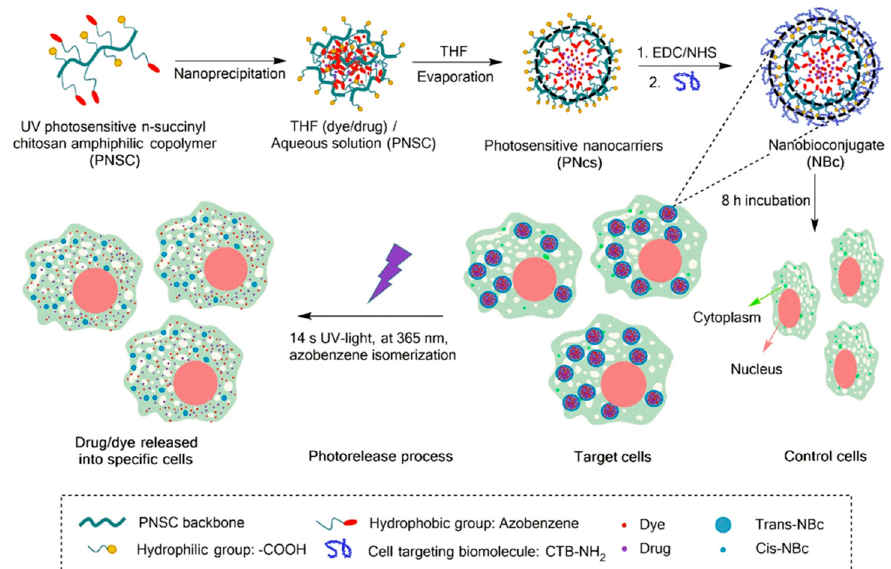
Figure 4. Illustration of PNc synthesis, nanocarrier self ‐ assembly, cargo co ‐ encapsulation, and further functionalization with the CTB. Selective uptake of the resultant nanobioconjugate and UV ‐ light induced cargo release into cardiomyocytes by an isomerization process of the azobenzene photosensitive molecule ‐ containing pothosensitive nanocarrier. Reprinted with permission from [99].